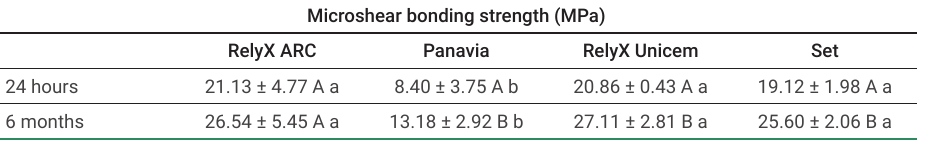
Table 2. Means of microshear bonding strength (MPa) between the resin cements and feldspathic ceramic, 24 hours and 6 months after the bonding procedure.